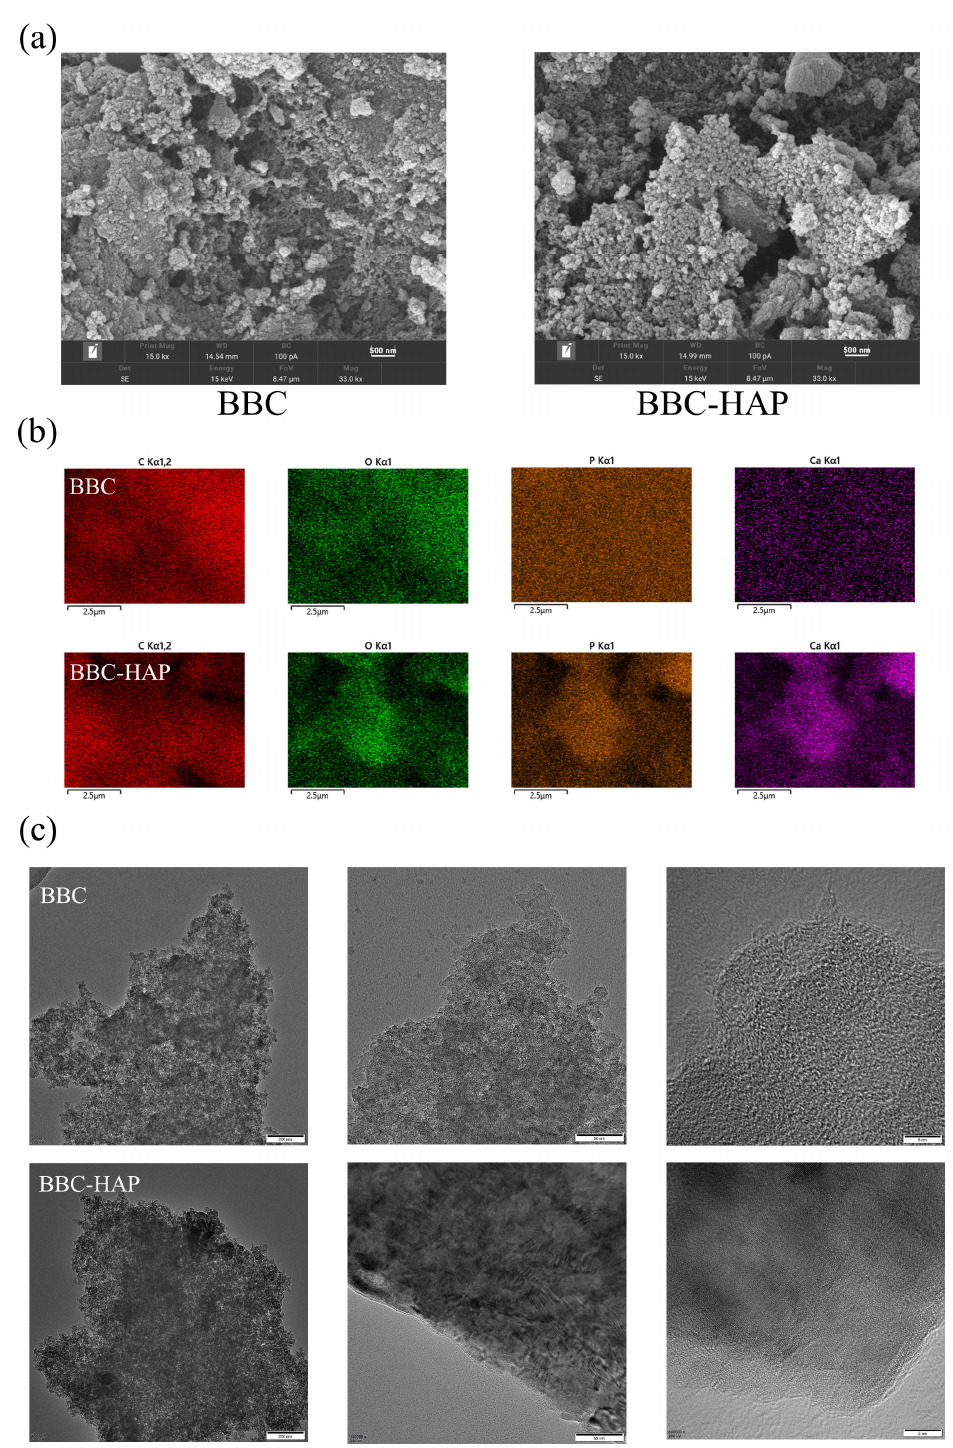
Figure 2. Study of the morphological properties of the BBC and BBC-HAP adsorbents by: ( a ) SEM micrographs ( b ) C, O, P, and Ca EDX elemental mapping images and ( c ) TEM images magnified at 200 kv.